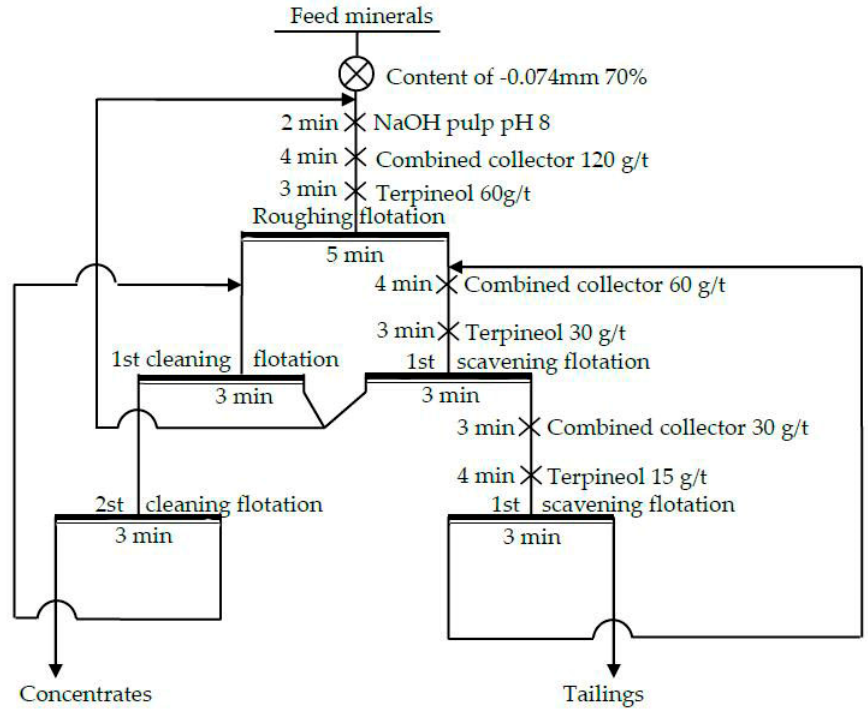
Figure 7. Chart of a closed-circuit flotation test. Table 4. Results of a closed-circuit flotation test.